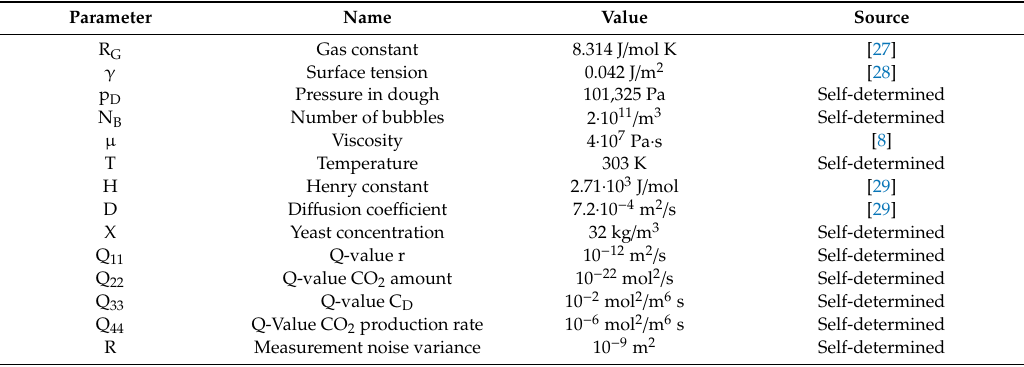
Table 1. Parameters used in the mathematical dough model and the extended Kalman